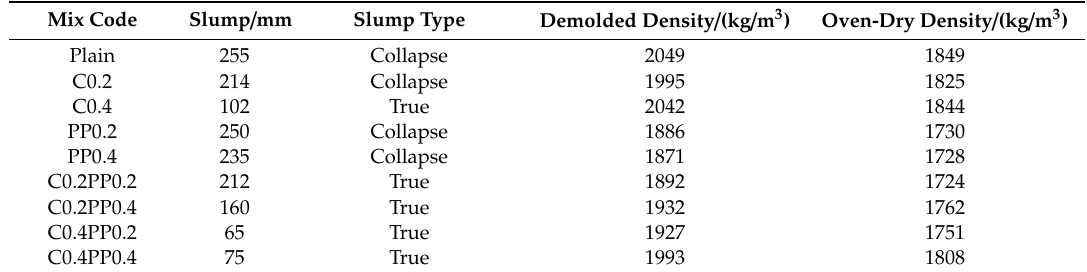
Table 7. Physical properties of LWAC with single and hybrid